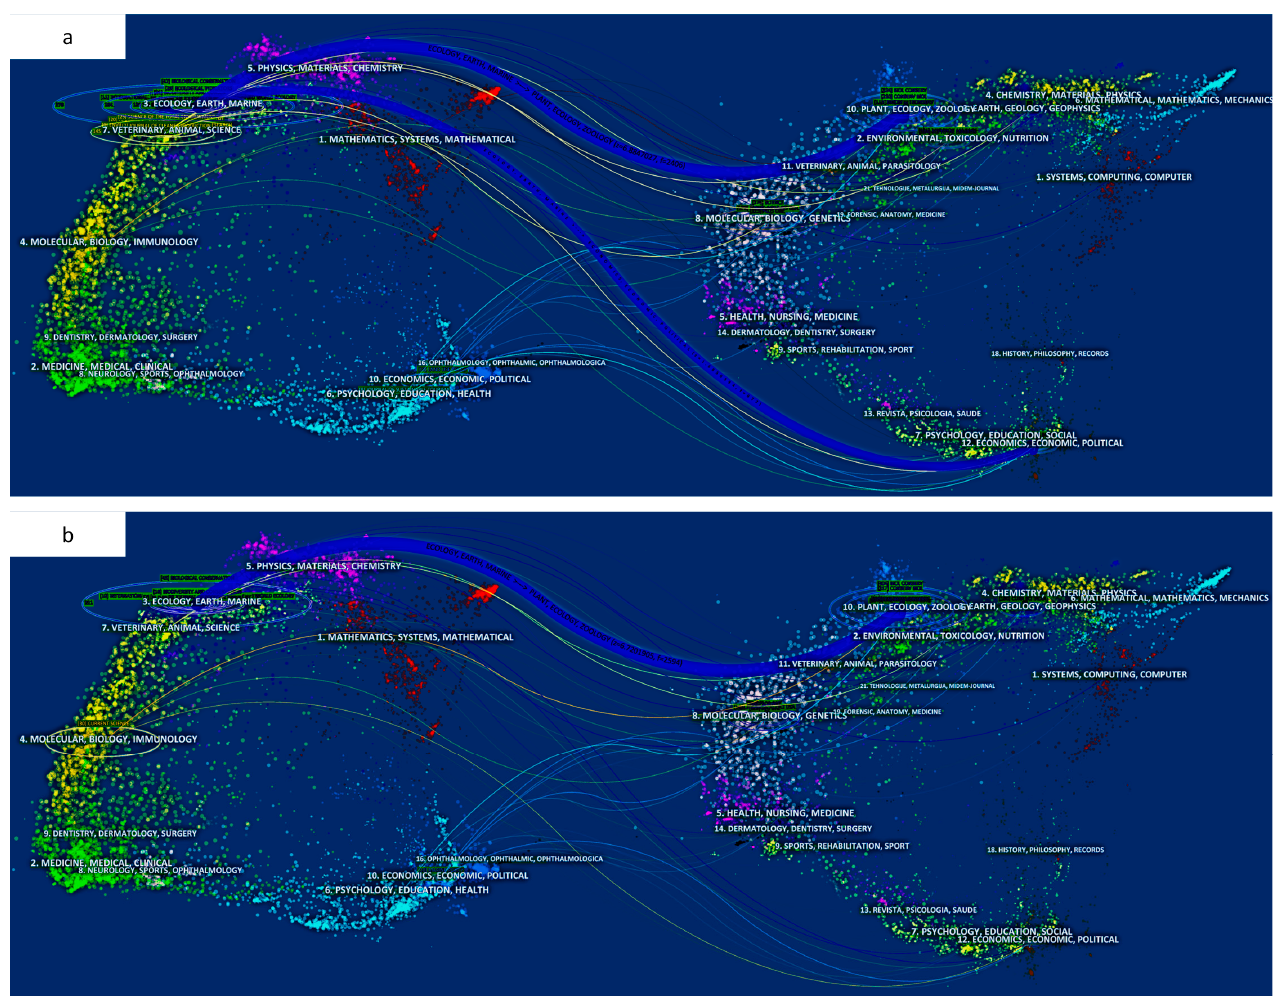
Figure 2. Dual-map overlay of articles citing China’s protected area policy (CPAP) ( a ) and India’s protected area policy (IPAP) ( b ) research. The left side indicates citing journals, the right side indicates cited journals, and the linkage paths denote the citation relationship.